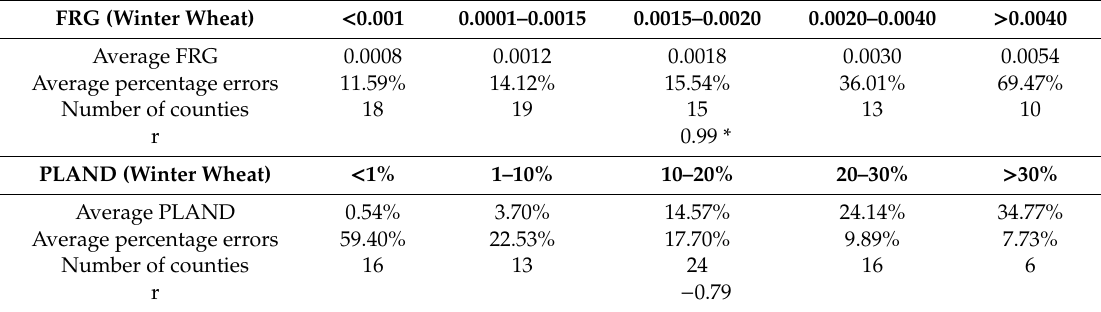
Table 10. Correlations between landscape metrics and percentage errors at the county level 1